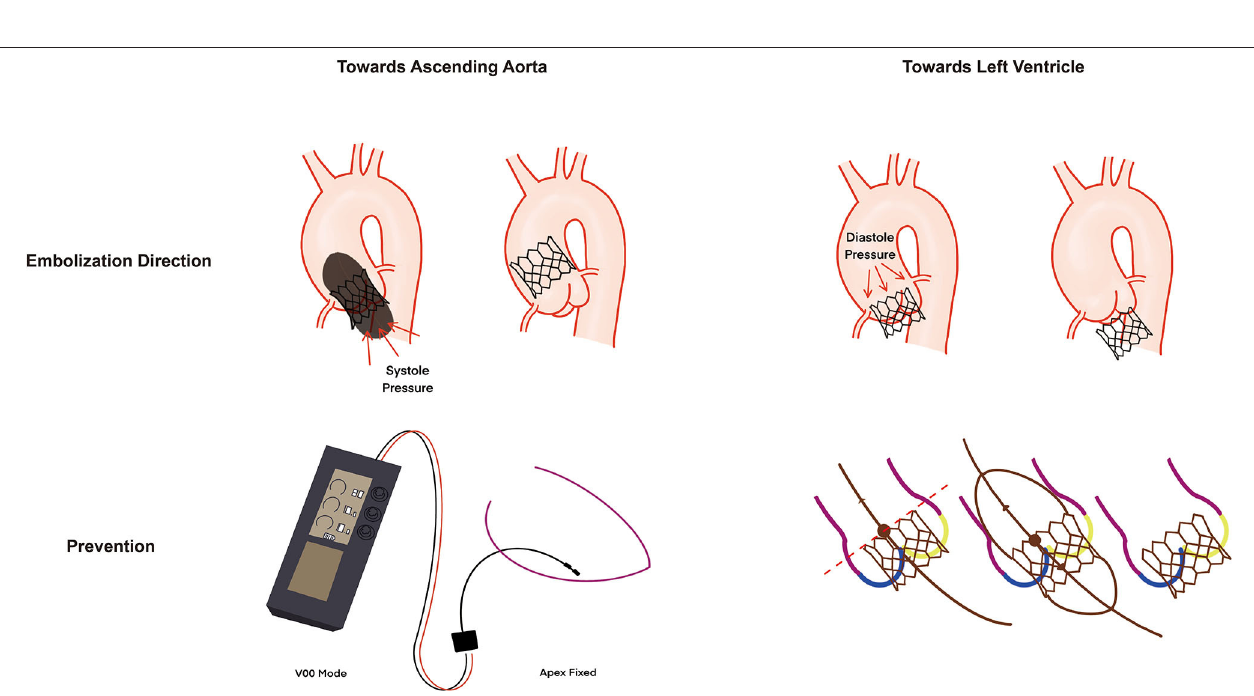
FIGURE 3 | Post-implantation evaluation. (A) Aortic root angiography for the evaluation of the second Sapien 3 THV. (B) Descending aorta angiography for the evaluation of the anchored Sapien 3 THV. (C) Aortic arch angiography for the exclusion of any occlusion of the main arteries.